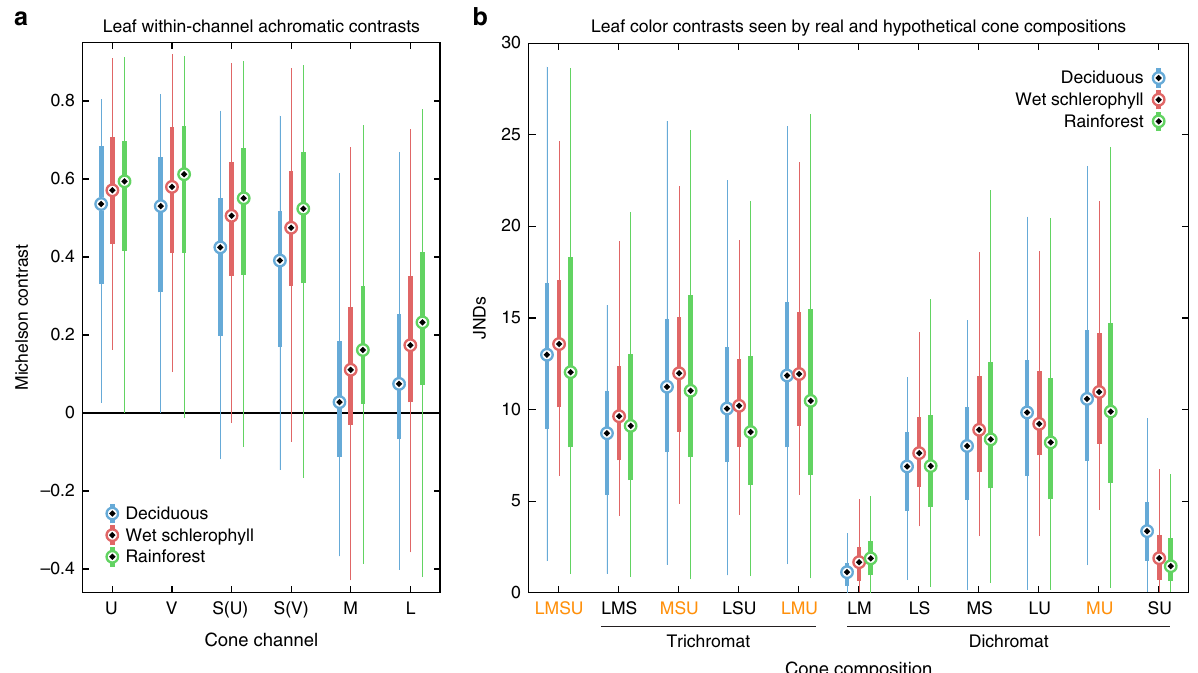
Fig. 5 The advantage of UV vision for visualizing leaf achromatic and color contrasts. Boxplots show the median, interquartile range (IQR), and lowest and highest data, within 1.5 IQR, below and above the IQR (outliers not shown). a Michelson 10 leaf achromatic contrasts seen by the different cone channels in different habitats. In each habitat, UV-cones saw higher leaf-contrast than all other cone channels at P < 0.0001. b Color contrasts in units of just noticeable differences (JNDs) 11 seen by a LMSU tetrachromat and all possible trichromatic and dichromatic combinations of avian photoreceptors, again separated by habitat. To make our results as general as possible across the animal kingdom, all photoreceptor compositions were assumed to have the same number of each photoreceptor class in an integrative unit. In each habitat, transforming a trichromat in the visible range (LMS) into a tetrachromat with a UV-cone (LMSU) enhanced color contrast at P < 0.0001. All cone compositions containing both a U- and M-cone (highlighted in orange) saw higher leaf color contrast than any other composition having the same number of cones at P < 0.0001. All P values were derived from paired two-sided sign tests, i.e., “ signtest ” in MATLAB. Details of statistical tests can be found in Table